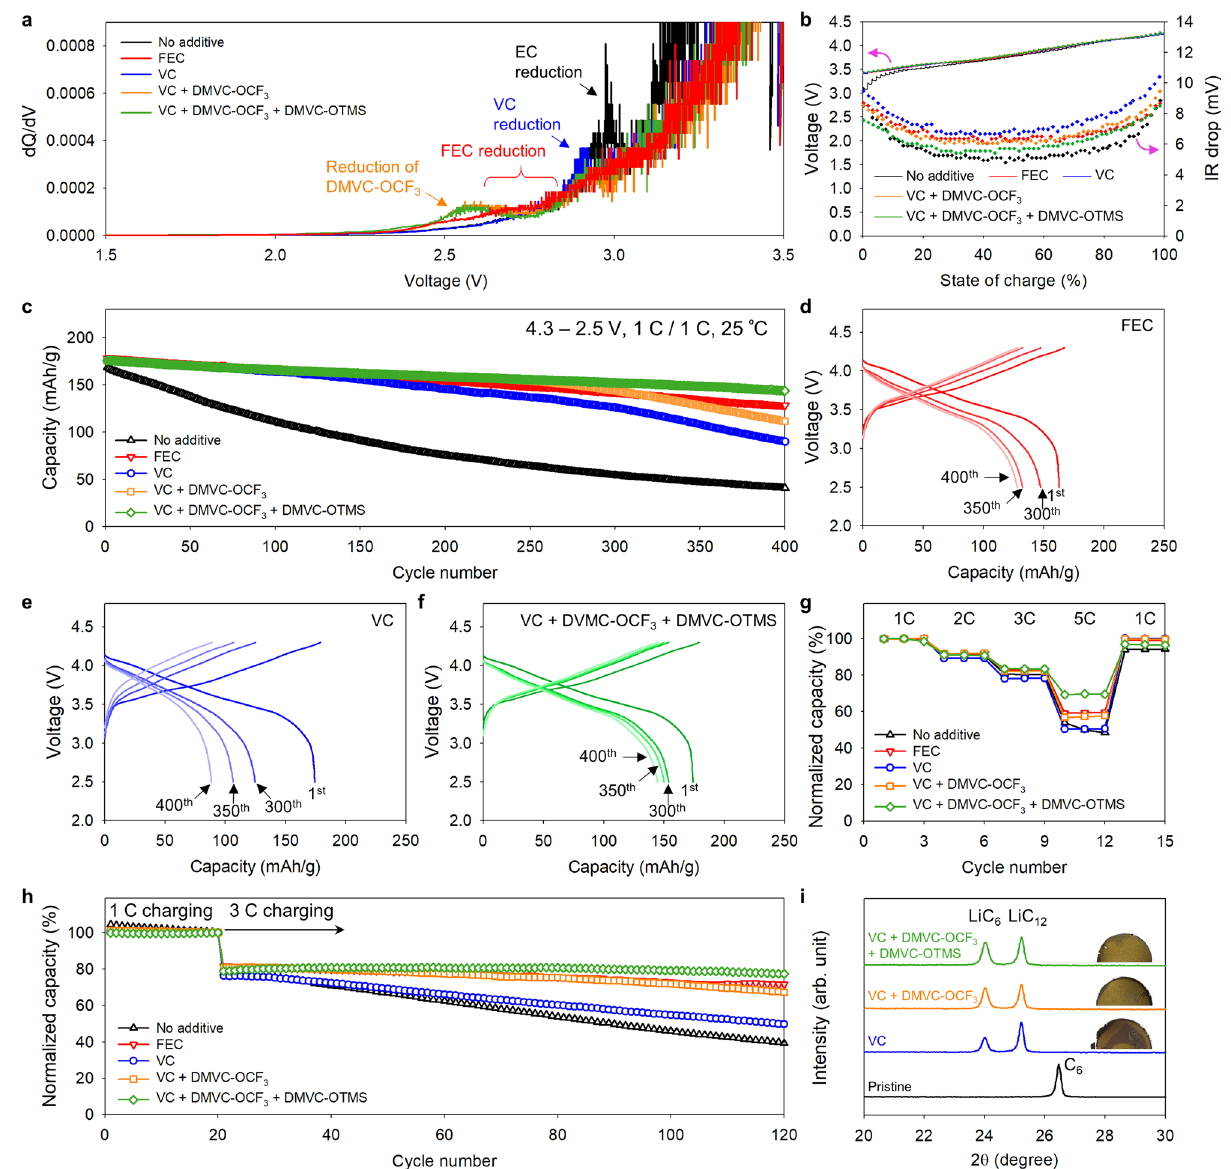
Fig. 4 Electrochemical performance of synthesized functional additives and fast charging capability. a d Q /d V graph of NCM811/Si-C full cells. (No additive: 1.15 M LiPF 6 in EC/EMC (3/7, v/v)) b Charge GITT pro fi les and IR drop of NCM811/Si – C full cells. c Cycle performance of NCM811/Si – C full cells at 1 C and 25 °C. d – f Voltage pro fi les of NCM811/Si – C full cells at a 1 C rate and 25 °C with FEC containing electrolyte ( d ), VC containing electrolyte ( e